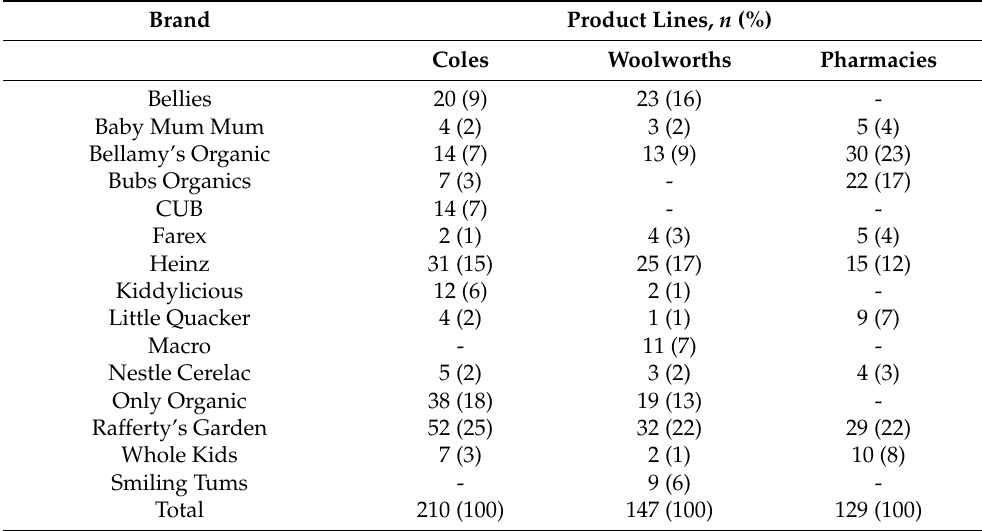
Table 2. Brand presence of commercial complementary foods (market share by product lines) in Coles Supermarkets, Woolworths Supermarkets and Chemist Warehouse Pharmacy. Brand